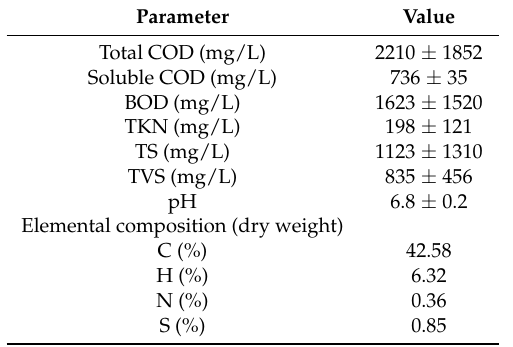
Table 2. Characteristics of organic solid waste.